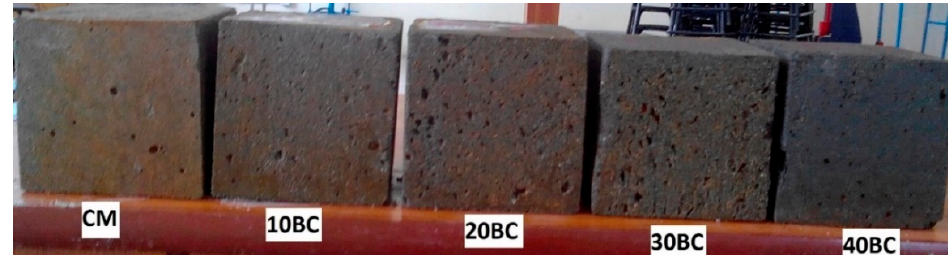
Figure 15. Strength loss of concrete mixes subjected to acid attack.